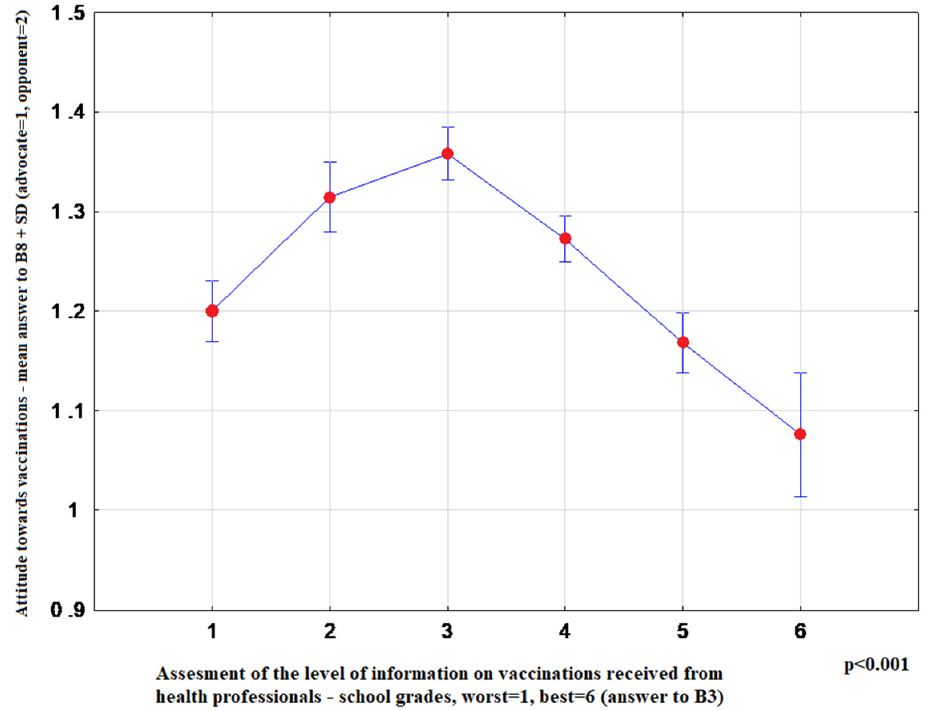
Figure 3. OY axis: Mean rank-answer to the question about the attitude toward vaccination (B8) + SD (advocate = 1; opponent = 2), OX axis: Level of information on vaccination received from health professionals-answers to B3-school grades system worst = 1, best = 6 (1 n = 820; 2 n = 614; 3 n = 1043; 4 n = 1422; 5 n = 794; 6 n =